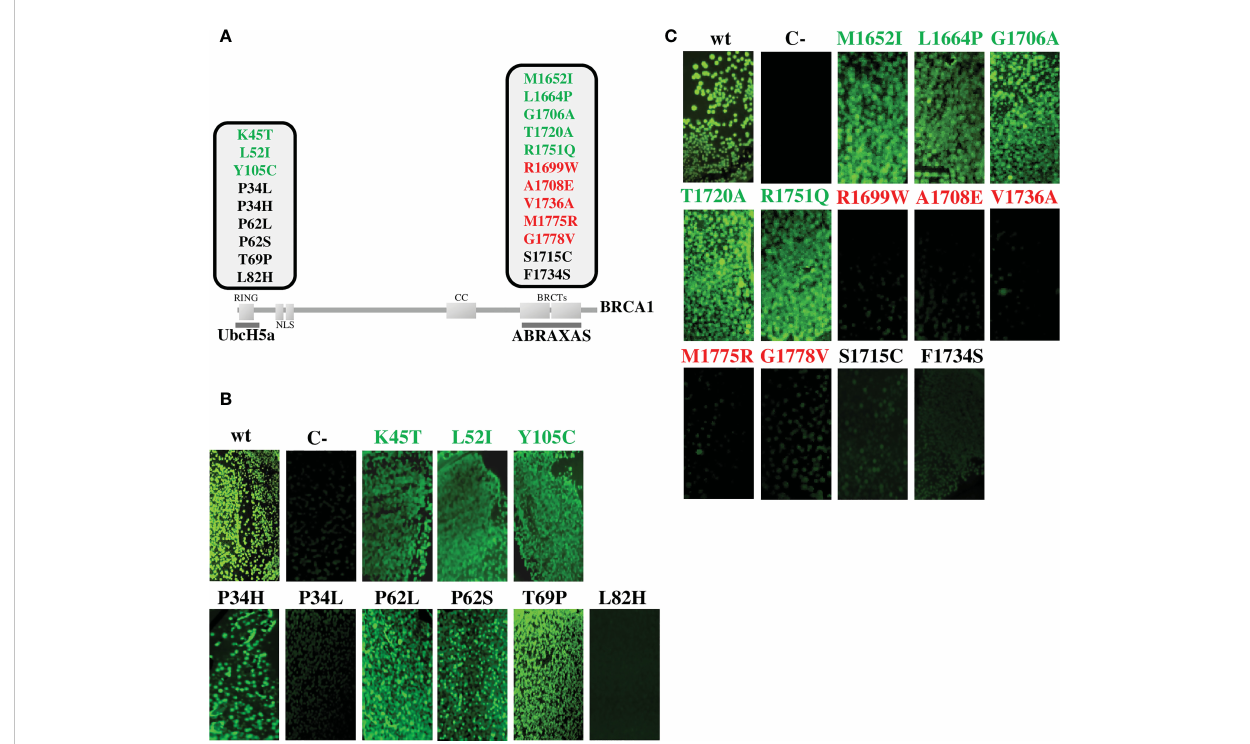
FIGURE 2 Functional evaluation of BRCA1 variants by GFP-reassembly in vitro assay. (A) Schematic representation of the BRCA1 protein showing functional domains, interacting proteins and variants analyzed in this study. The benign variants (class 1) are shown in green, the pathogenic variants (class 5) are shown in red and the discordant variants are shown in black. The partner proteins are depicted underneath their respective BRCA1 interacting domains. (B) Detection of BRCA1-UbcH5a binding by GFP-reassembly in vitro assay. Wild-type NfrGFP-UbcH5a/BRCA1-CfrGFP peptides (wt) and non-cognate NfrGFP-UbcH5a/Z-CfrGFP peptides (C-) were included as internal positive and negative control, respectively. (C) Detection of